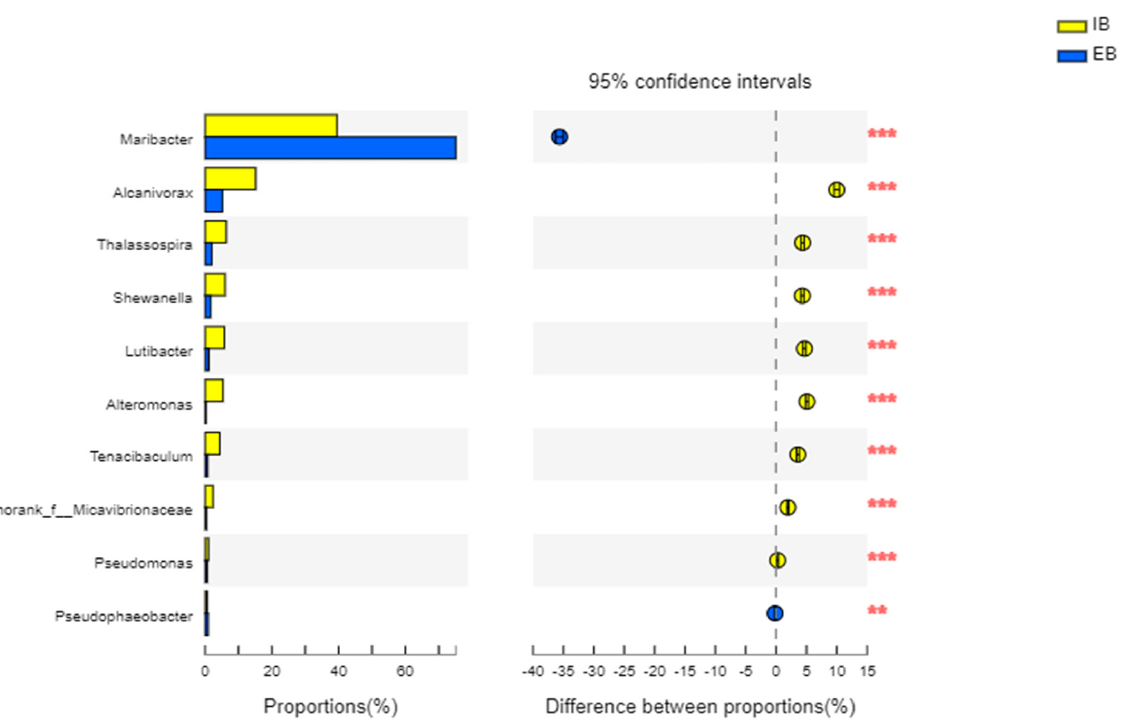
Figure 6. Fisher’s exact test bar plot at the genus level for the immobilized petroleum–degrading bacteria beads at different areas of the bioreactor (water inlet site (IB); water outlet site (EB), shown in yellow and blue, respectively). Asterisks (*) on the right represent significant differences: **: p -value was between 0.001 and 0.01; ***: p -value was below 0.001.